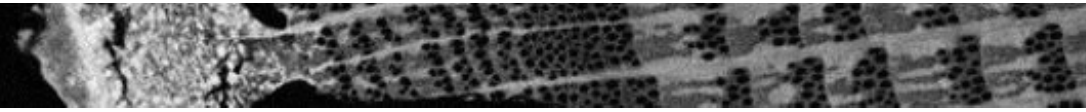
Figure 18. A 3D increment core of oak scanned at 35 μ m resolution showing bark, early-wood vessels, and small and wide growth rings.